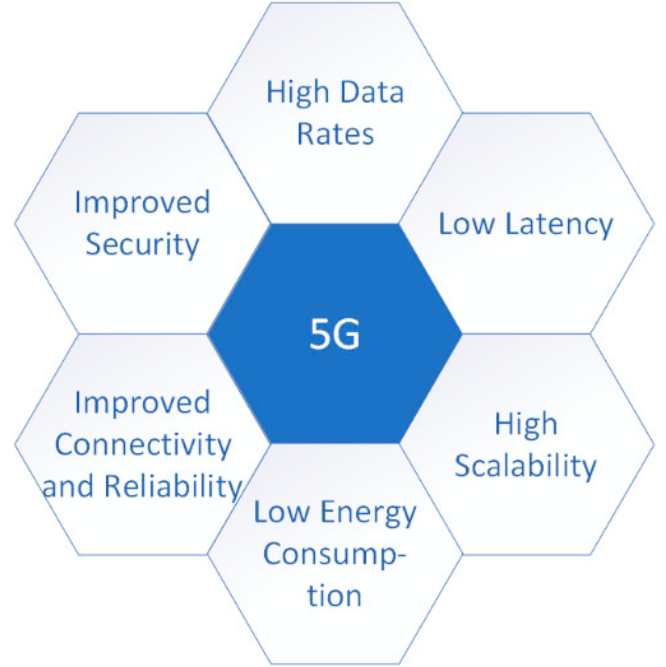
Figure 3. Key 5G capabilities for assistive technology.